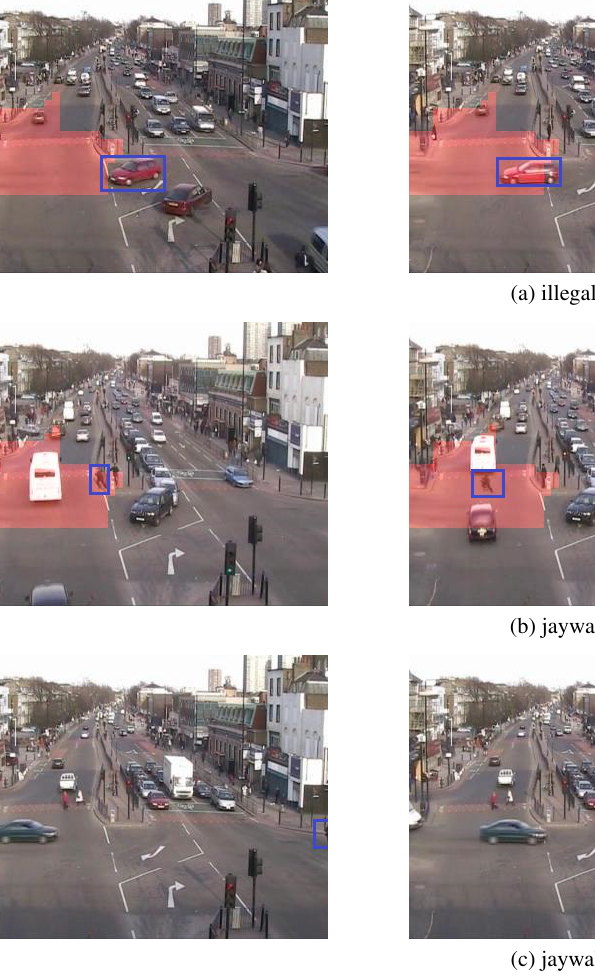
Figure 4: Examples of detected anomaly using our GP models (abnormal regions are denoted in red whilst the corresponding abnormal object is highlighted with a